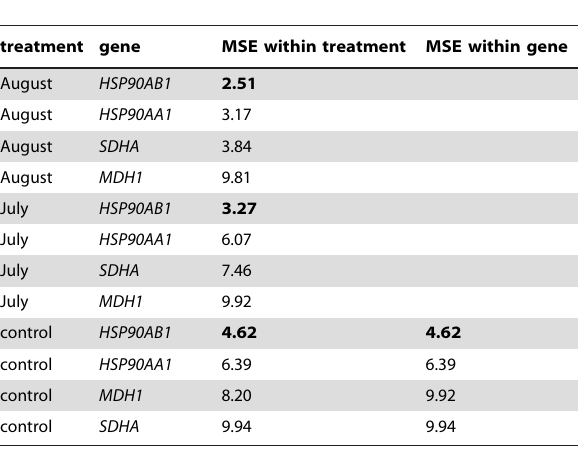
Table 4. Minimum square error (MSE) within and across treatments for HSP90AA1, HSP90AB1, MDHA and SDHA genes.